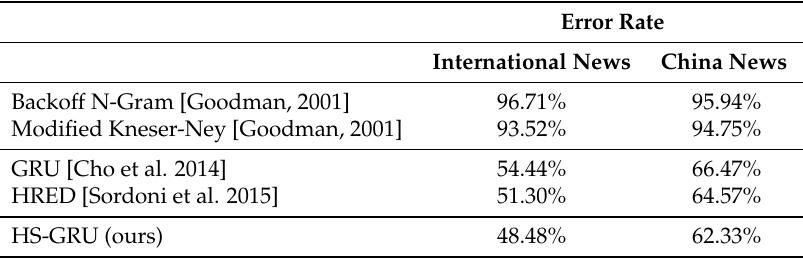
Table 3. Error rate on